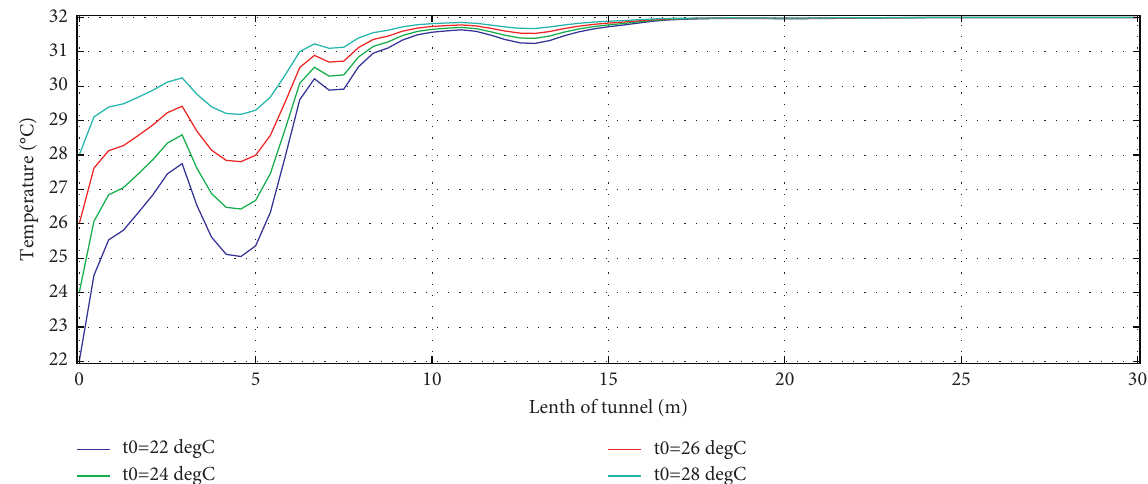
Figure 13: Wall surface temperature distribution at different air temperatures.